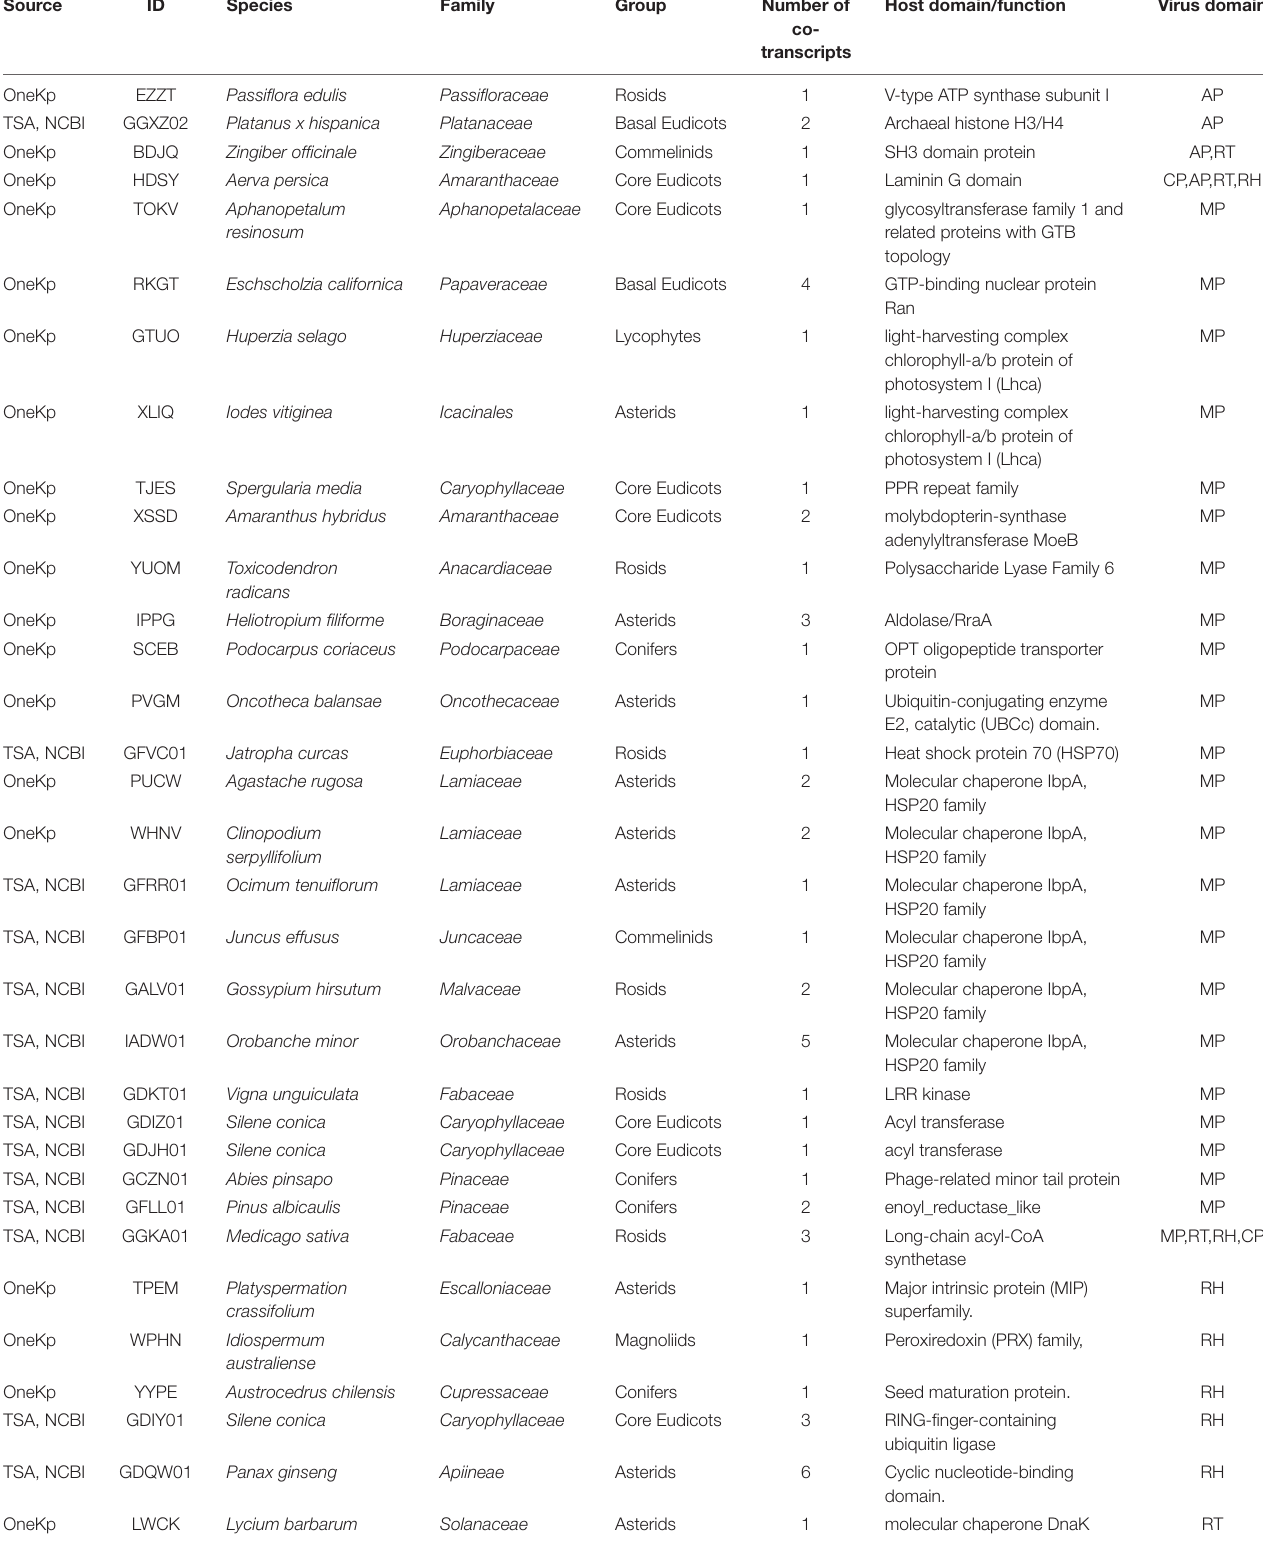
TABLE 1 | List of co-transcripts containing caulimovirid and plant sequences identified in this work.